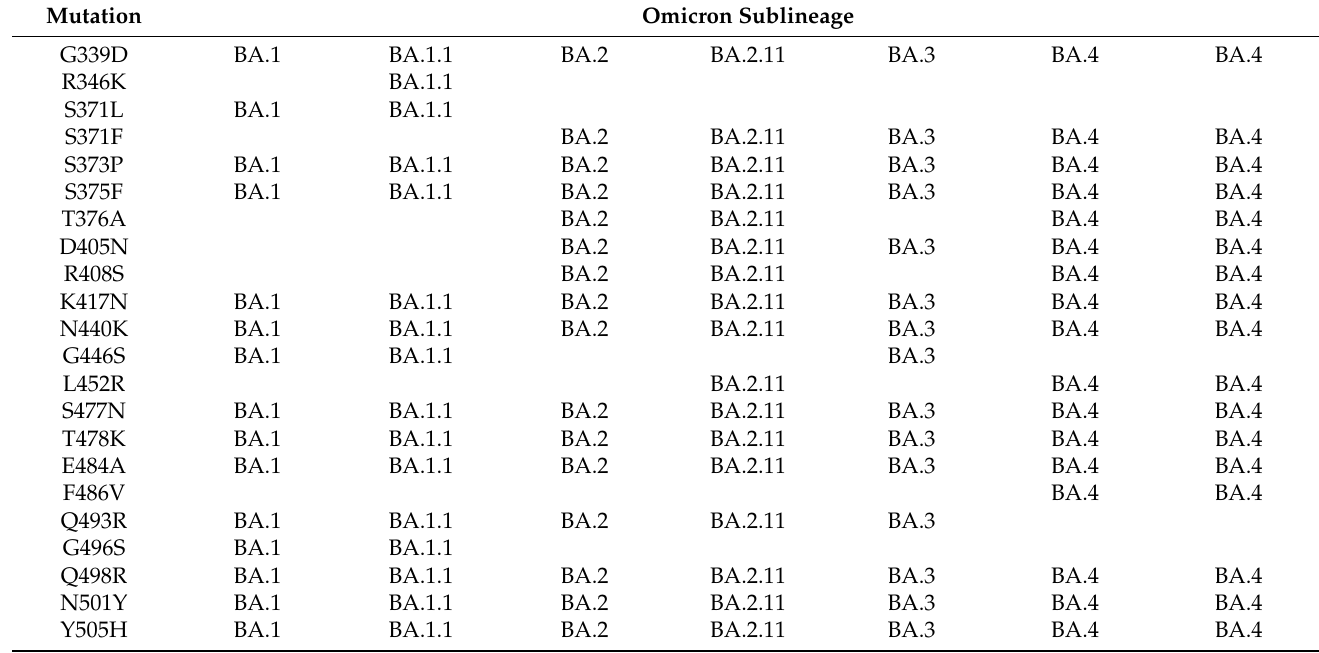
Table 1. Mutations of the S-RBD in different Omicron